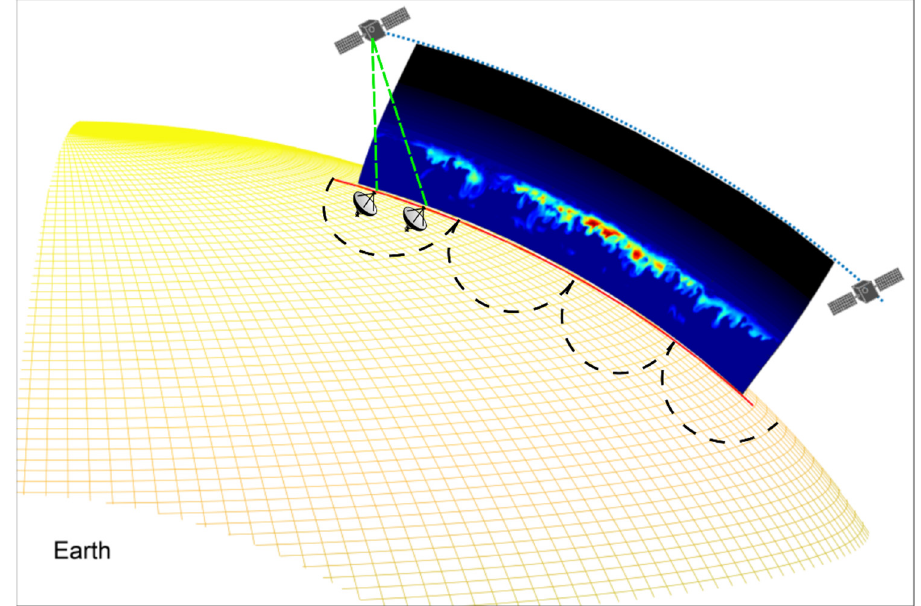
Figure 1. An illustration of the satellite, the ground receivers and the retrieval of the attenuation field. The blue dotted line shows the trajectory of the satellite, the black dashed lines show the − 3 dB footprint contour of the satellite signals, the red solid line is the ground track and also where the receivers are placed.